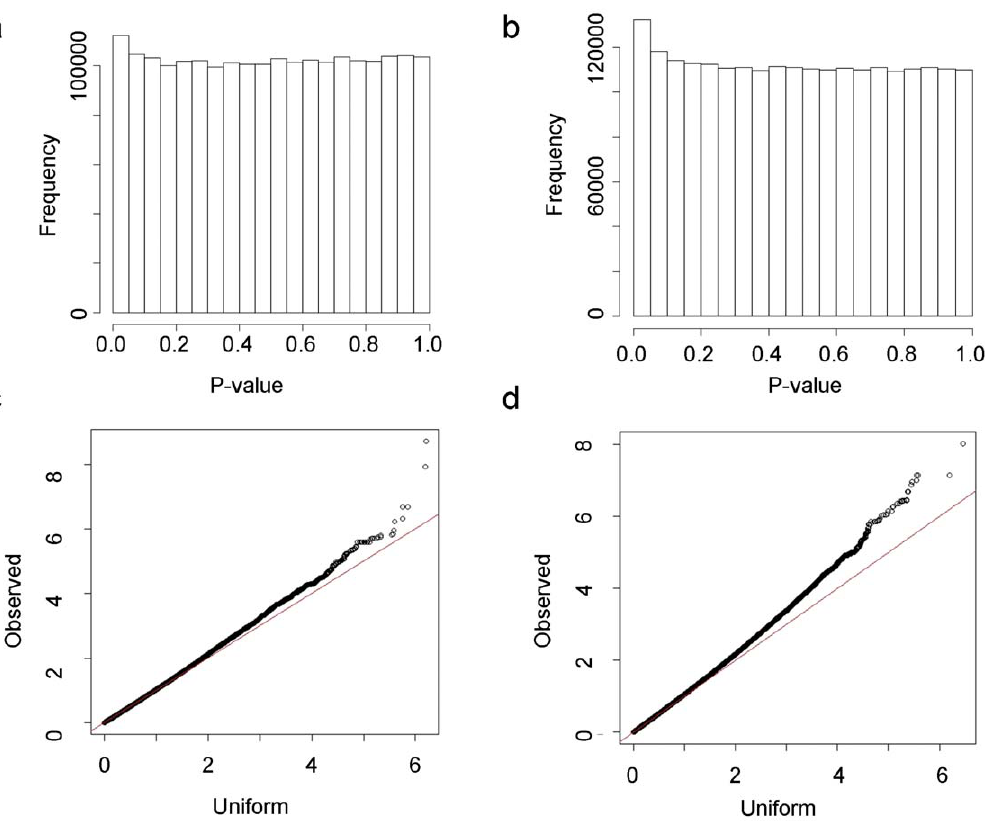
Figure 3. Histograms of p-values from tests of association between individual SNP markers and the intron expression phenotype in the CEU (a) and YRI (b) populations. Quantile-quantile plots of log 10 of the p-values from the CEU (c) and YRI (d) association tests against log 10 of random values, drawn from the uniform distribution.